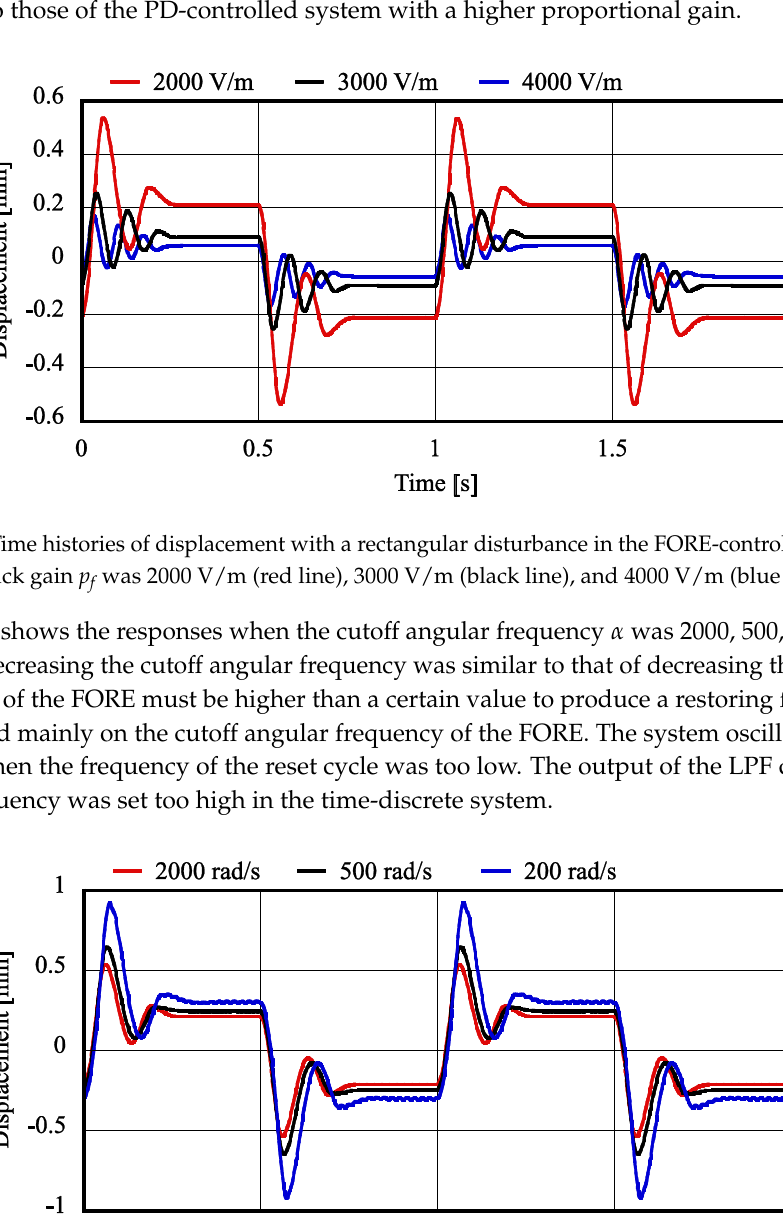
Figure 10. Time histories of displacement with a rectangular disturbance in the FORE-controlled system. The cutoff angular frequency was 2000 rad/s (red line), the same as the response in Figure 7, 500 rad/s (black line), and 200 rad/s (blue